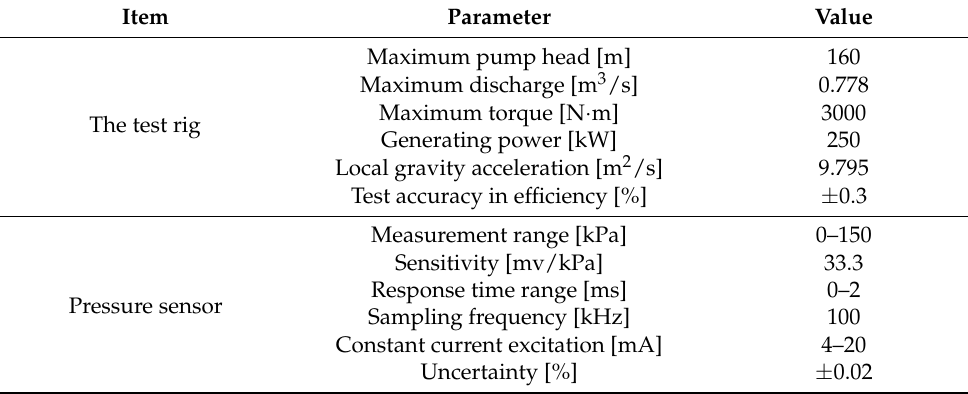
Table 2. Characteristic parameters of the test rig and pressure sensor.